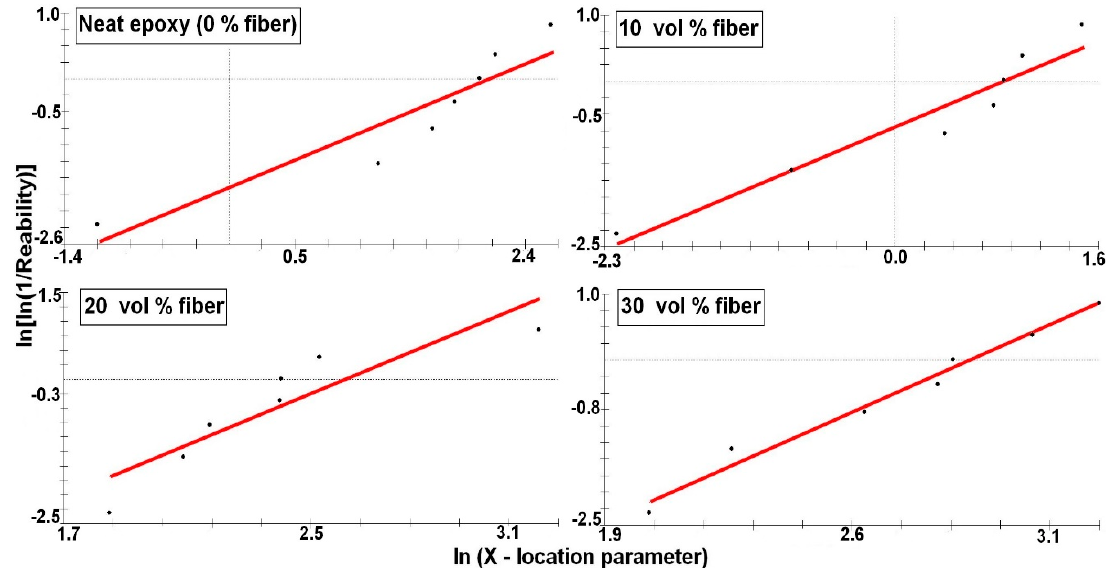
Figure 9. Total elongation Weibull plots for the epoxy composites reinforced with different volume fractions of caranan fiber.